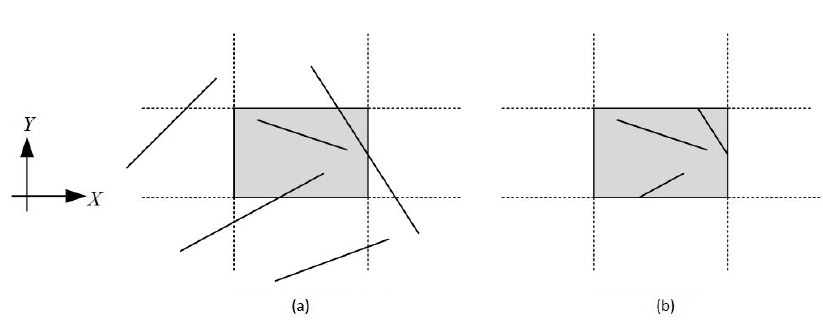
Figure 1. ( a ) Before and ( b ) after application of line clipping in two dimensions.